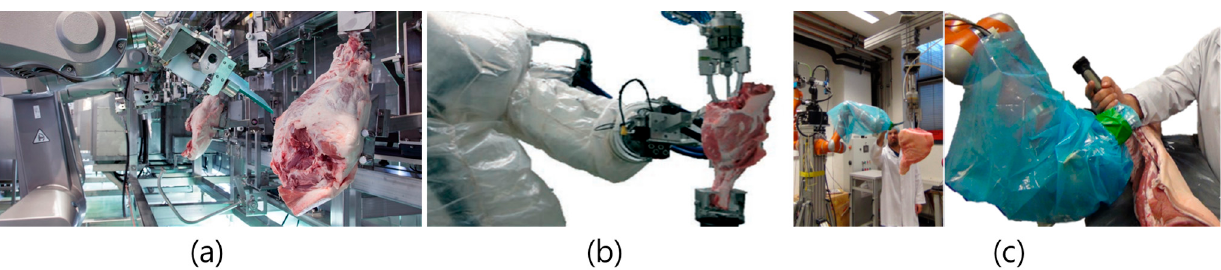
Figure 5. A pork meat deboning robot technique. ( a ) Mayekawa Hamadas RX (Reprinted with permission from Mayekawa, Japan); ( b ) a ham deboning using a robot [52] (from Subrin et al. Analysis of the human arm gesture for optimizing cutting process in ham deboning with a redundant robotic cell. Reprinted with permission of Emerald Publishing Limited, Bingley, Copyright © 2014); ( c ) a meat deboning using co-robot [55].